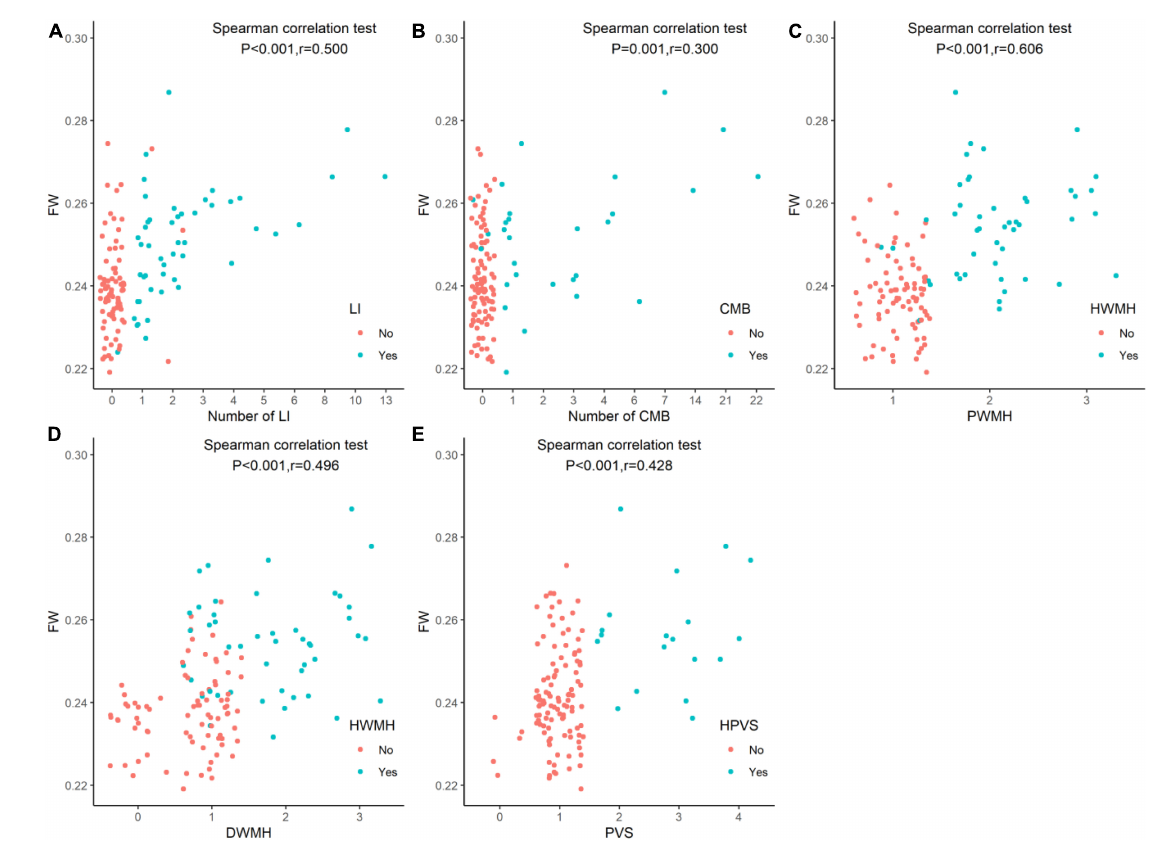
FIGURE1 Comparison of extracellular fluid volume of white matter among study participants according to cerebral small vessel disease markers. White matter FW values were associated with the CSVD MR markers of LI (A) , CMB (B) , PWMH (C) , DWMH (D) , and PVS (E) ( P < 0.05). FW, free water; LI, lacunar infarction; CMB, cerebral microbleed; DWMH, deep white matter hyperintensity; PWMH, periventricular white matter hyperintensity; HWMH, high-grade white matter hyperintensity; HPVS, high-grade perivascular